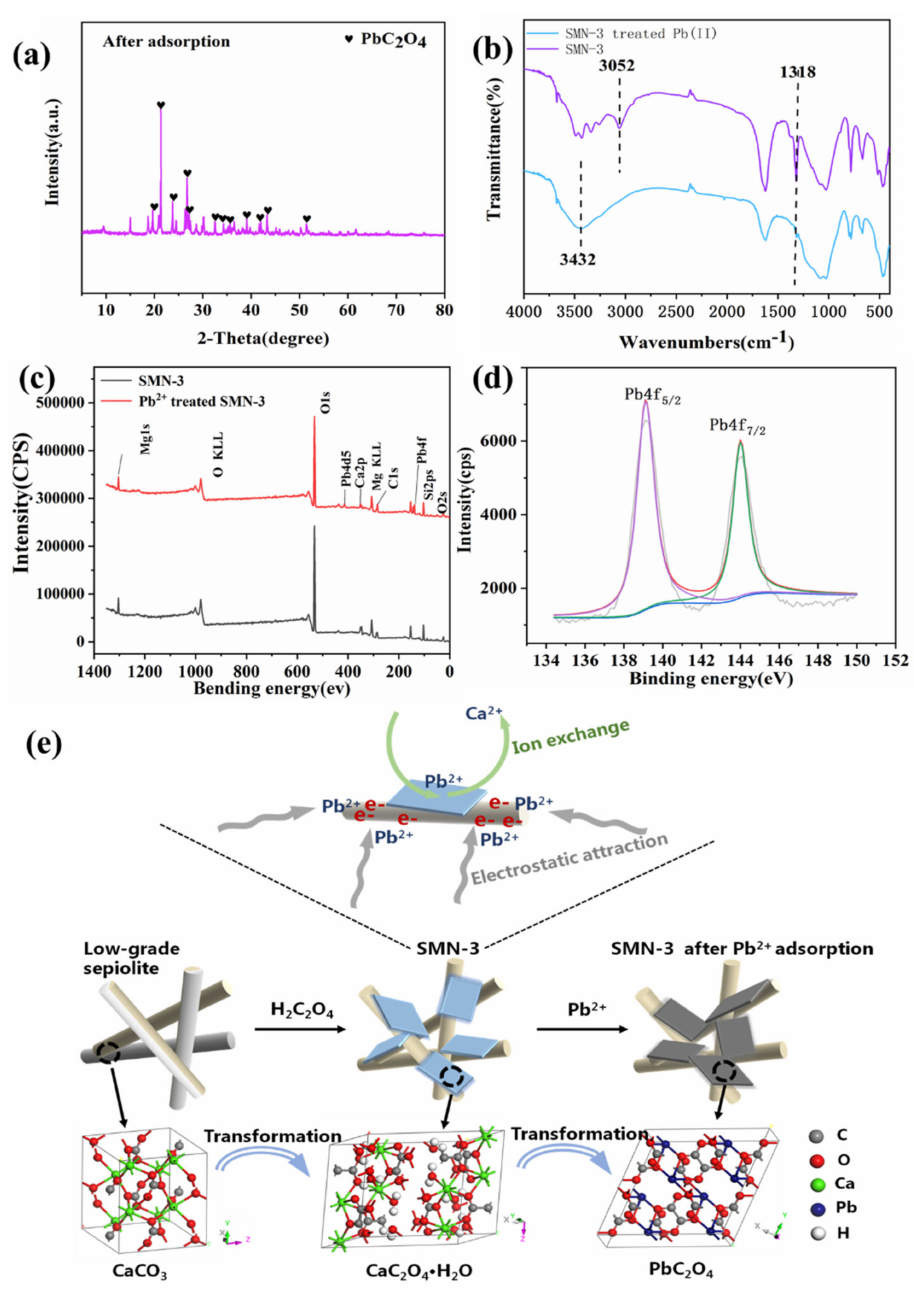
Figure 6. ( a ) XRD pattern of SMN-3 after adsorption; ( b ) FTIR spectrum of SMN-3 before and after adsorption; ( c ) Full-scan XPS spectra of before and after absorption; ( d ) high-resolution scan of Pb4f ( e ) adsorption